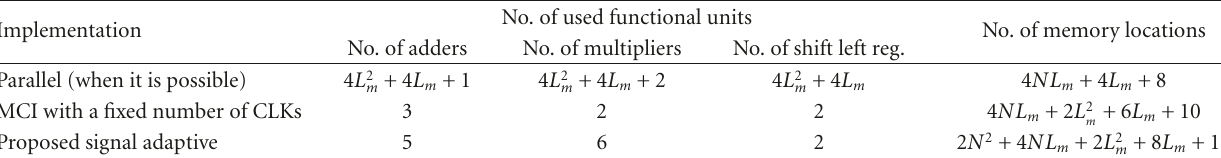
Table 8: Hardware complexity of the considered implementations of 2D systems.